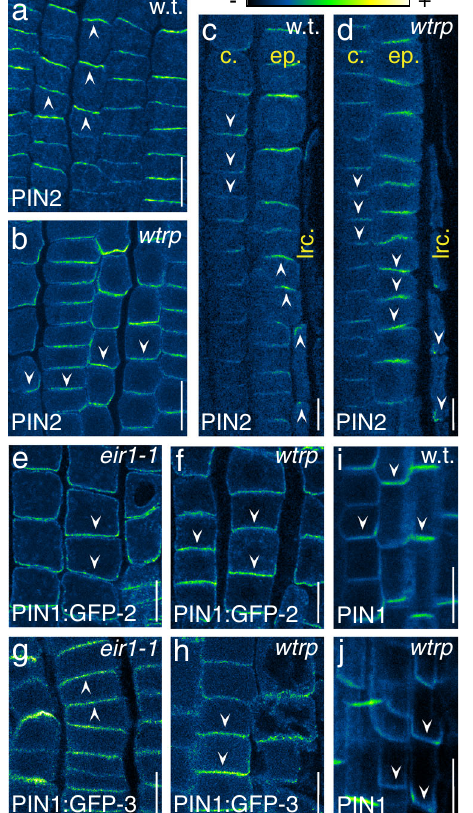
Fig.2|PINpolarityswitchesin wavtriple rootmeristems. PIN2immunostaining in wild type (w.t.; a , c ) and wav triple ( wtrp ; b , d ) root meristems at 5 DAG. a , b Epidermis cells; c , d cortex ( ‘ c. ’ ), epidermis ( ‘ ep. ’ ), and LRC ( ‘ lrc. ’ ) cells. Immunostaining of PIN2::PIN1:GFP-2 ( e , f ) and PIN2::PIN1:GFP-3 ( g , h ) reporter pro- teins in 5 DAG eir1-1 ( e , g ) and wav triple ( f , h ) root meristem epidermis cells. PIN1 immunostaining in 5 DAG wild type (w.t.; i ) and wav triple ( wtrp ; j ) root stele cells. Three independent experiments were performed for ( a – j ) with similar results. Arrowheads indicate the polarity of PIN signals. Scale bars: a , b =20 μ m; c – j =10 μ